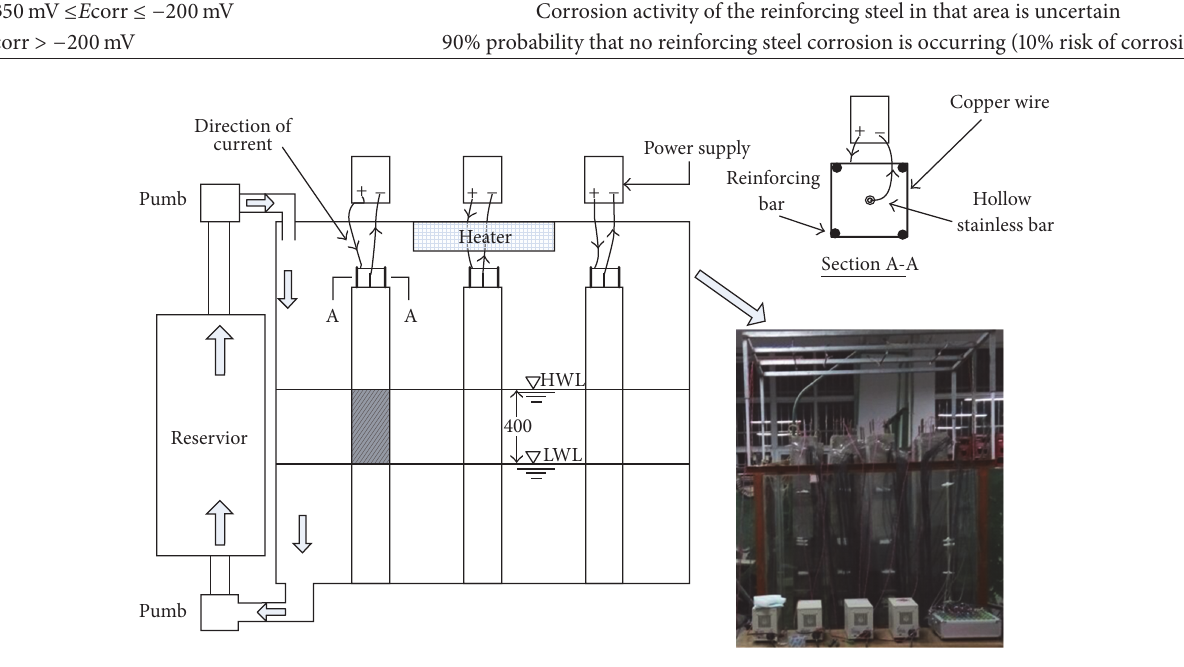
Figure 3: Marine environment simulation system and electrical connection.